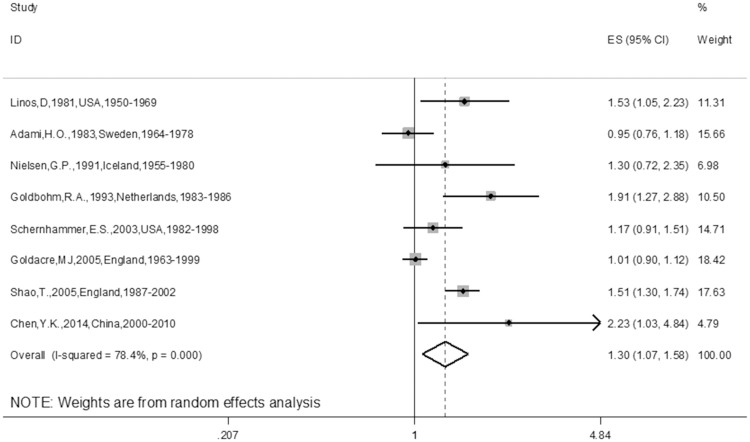
Forest plot of risk of CC associated with cholecystectomy in general population.Note: CC represents colon cancer.